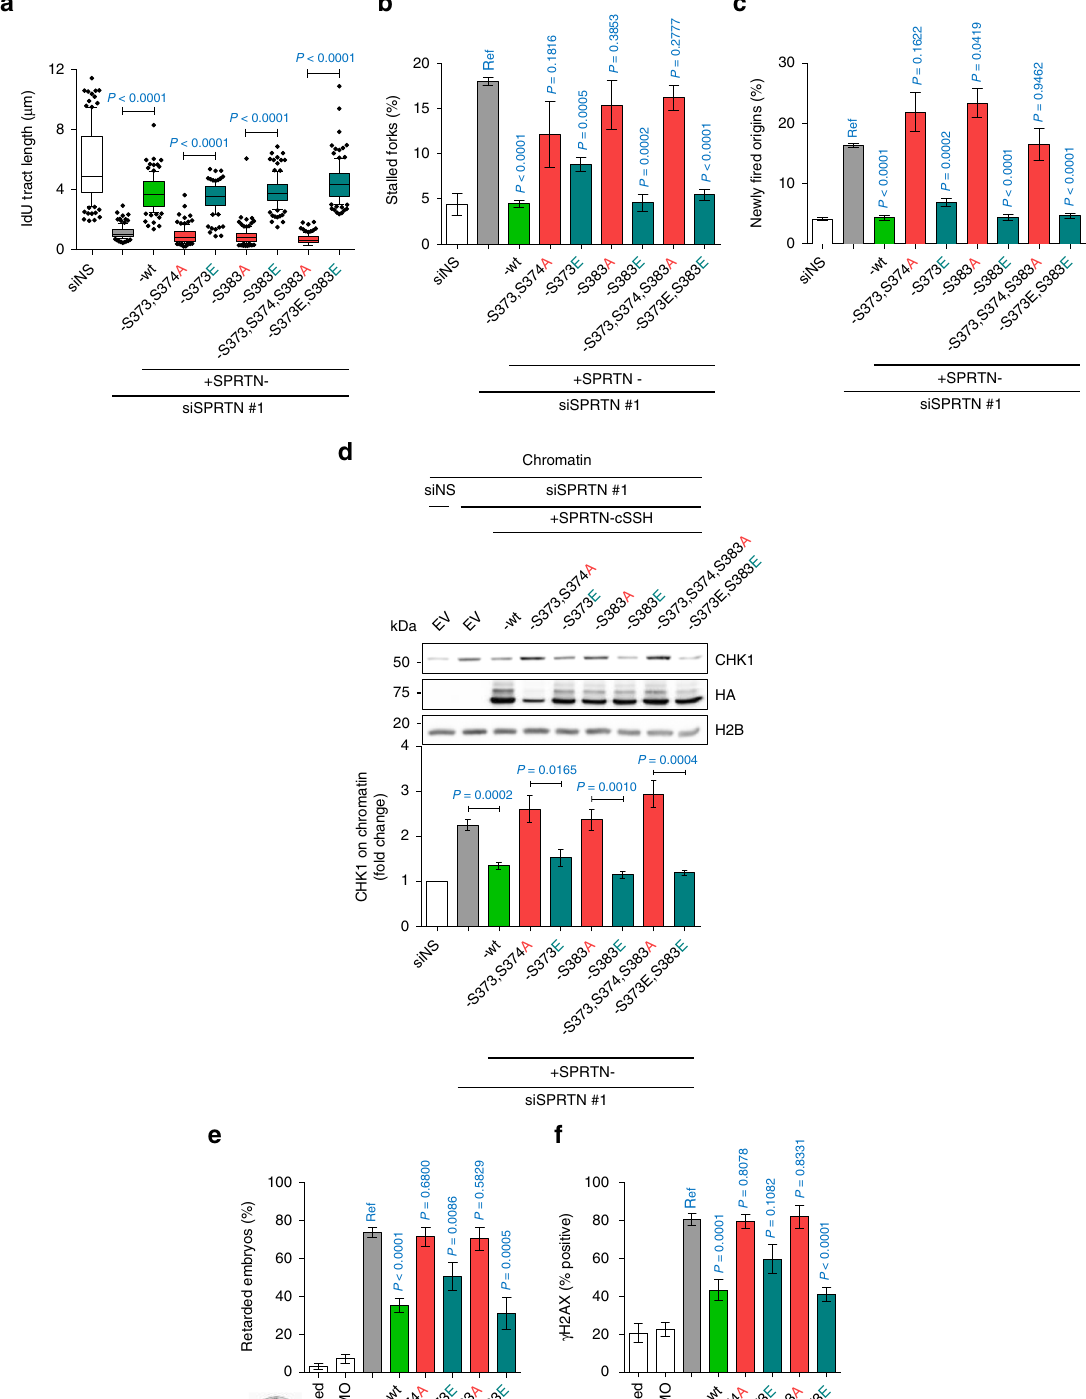
regulation of SPRTN has a considerable interest given its pleio- tropic protease activity. SPRTN is physically present at DNA replication forks and the SPRTN gene is essential in metazoan from early embryogenesis. It has been previously proposed that ssDNA promotes SPRTN-dependent substrate cleavage while dsDNA induces SPRTN auto-cleavage to negatively regulate